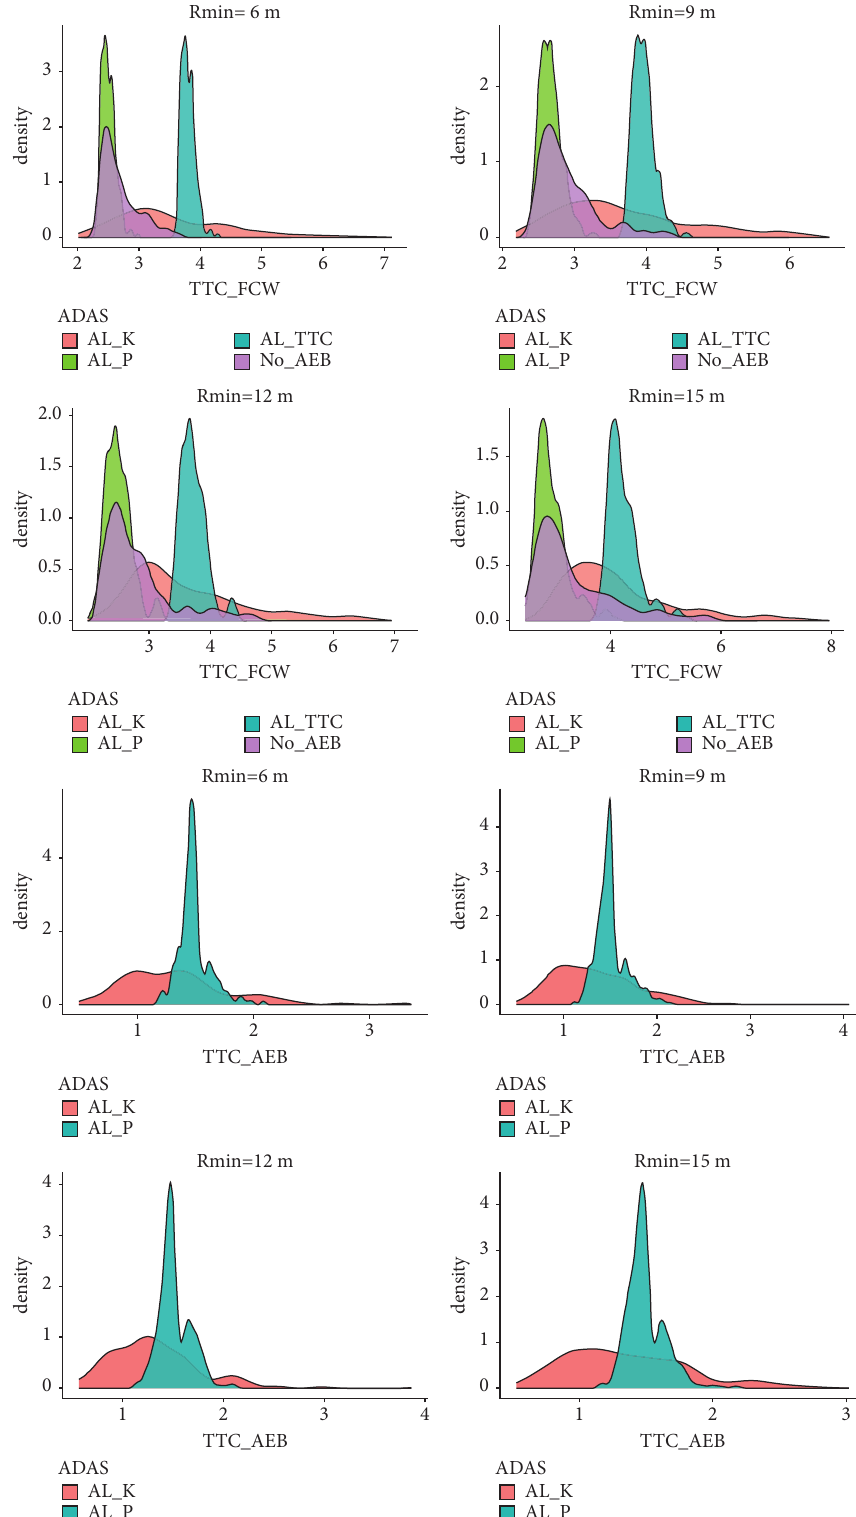
Figure 5: The kernel density estimate of the calculated TTC for FCW and AEB systems based on different safety margin ( R different algorithms. (a) R min � 6m. (b) R min � 9m. (c) R min � 12m. (d) R min �